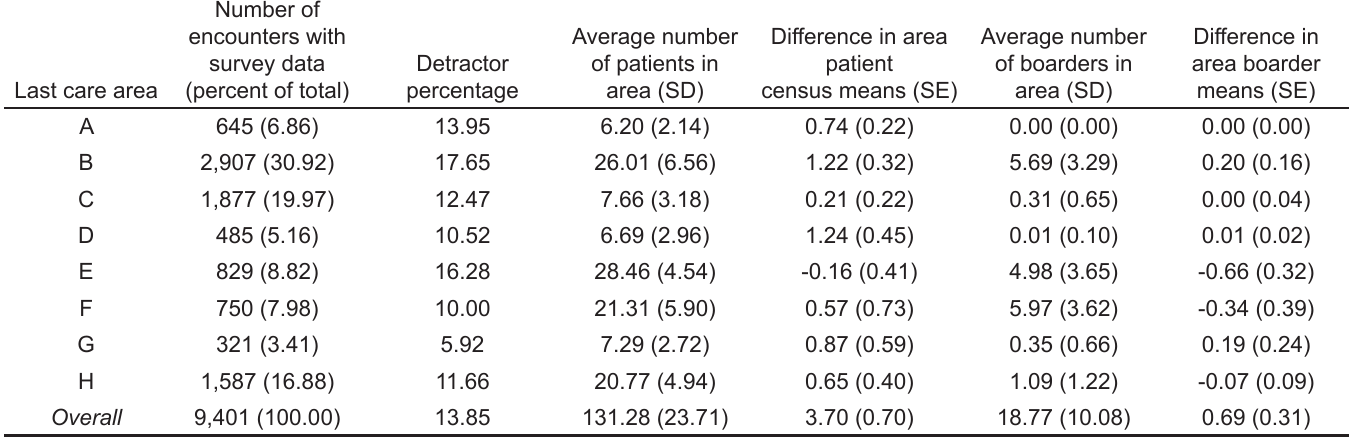
Table 2. Summary statistics on survey response and average number of patients (and boarders) at the time of a patient’s arrival to their last care